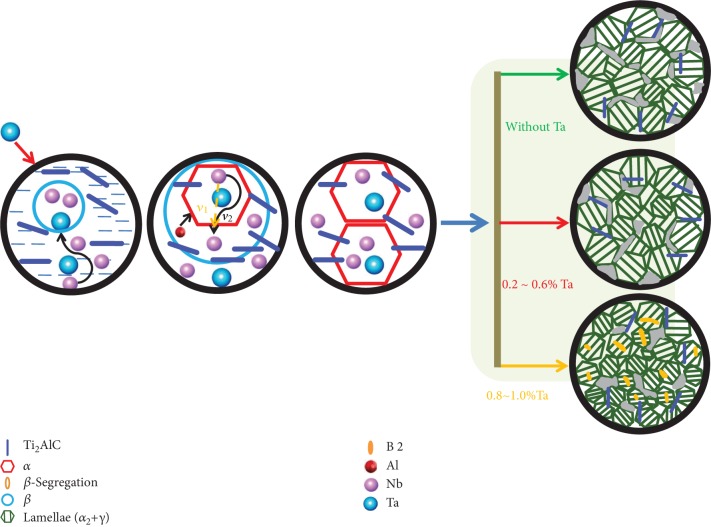
Schematic diagram of the Ti46Al2.6C8NbxTa alloys.